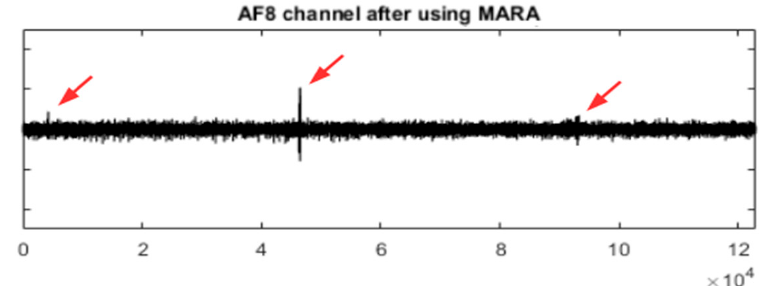
Figure 11. The AF8 channel of AEEG after using the MARA method. The red arrows point to some artefacts that have not been well filtered.